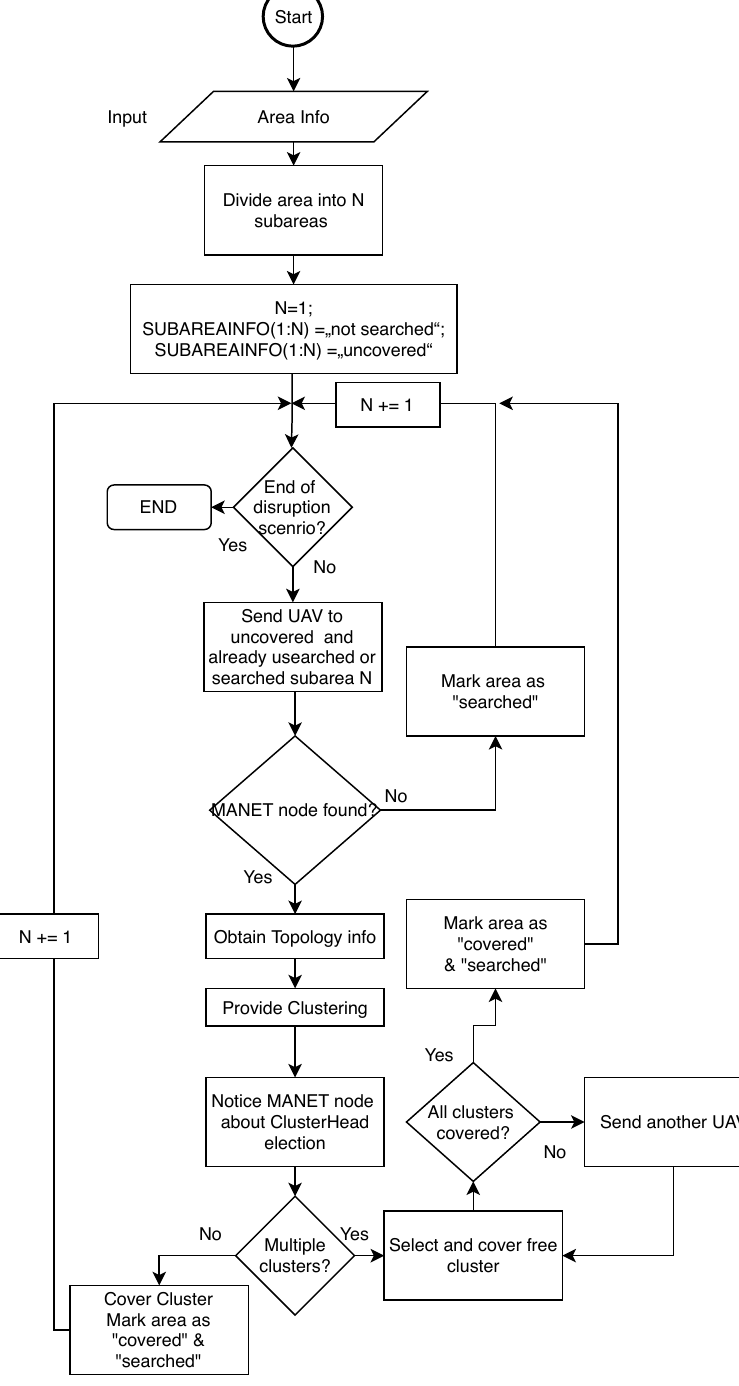
Figure 12. The DRONET initial and search stage